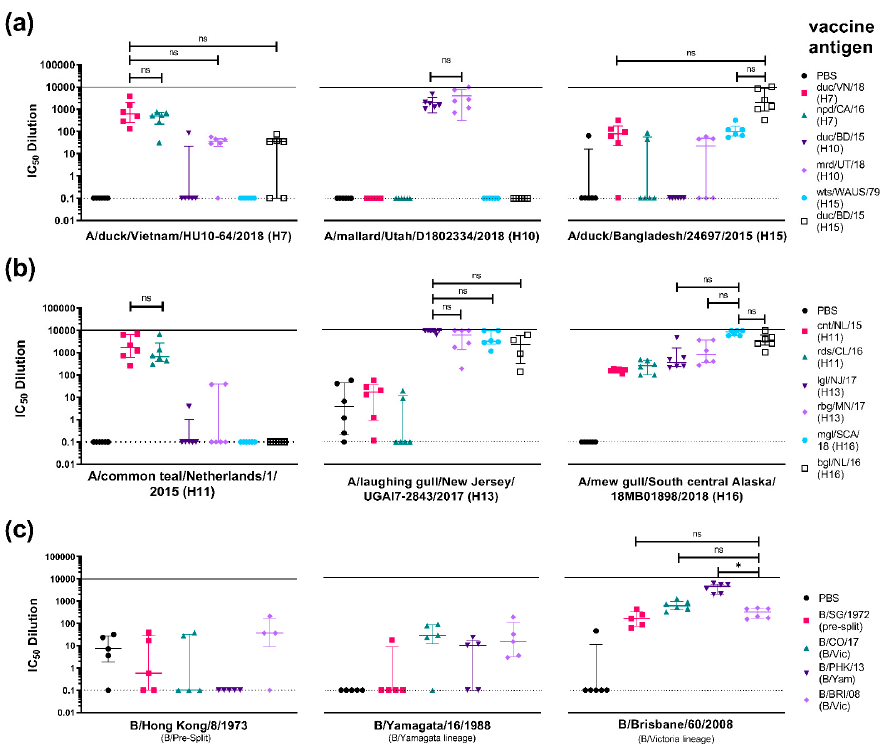
Figure 9. In vitro neutralizing activity as shown by IC 50 dilution of mouse sera vaccinated with HA antigens from the closest phylogenetically related IAV subtypes, ( a ) H7, H10, and H15, ( b ) H11, H13 and H16, and ( c ) IBV HA antigens from pre-split, Yamagata and Victoria like-lineages. Neutralizing activity of sera from vaccinated mice were tested against homologous and heterologous strains from the same subtype and a representative strain within the related subtypes. ( a ) IAV H7/H10/H15 study. Six groups consisting of 6 mice each ( n = 6/group) were vaccinated with 50 µ g of pEVAC expressing A/duck/Vietnam/HU10-64/2018 (H7) (duc/VN/18) (pink square), A/northern pintail duck/California/UCD1582/2016 (H7) (npd/CA/16) (green triangle) ( n = 6), A/duck/Bangladesh/24268/2015 (H10) (duc/BD/15) (violet inverted triangle), A/mallard/Utah/D1802334/2018 (H10) (mrd/UT/18) (purple diamond), A/wedge-tailed shearwater/Western Aus- tralia/2576/1979 (H15) (wts/WAUS/79) (light blue circle), and A/duck/Bangladesh/24697/2015 (H15) (duc/BD/15) (hol- low black square), respectively. Terminal bleeds (70 dpi) were tested against H7 PV duc/VN/18, H10 PV mrd/UT/18, and H15 PV duc/BD/15 as shown on the x-axes. ( b ) IAV H11/H13/H16 study. Six groups consisting of 6 mice each ( n = 6/group) were vaccinated with 50 µ g of pEVAC cloned with A/common teal/Netherlands/1/2015 (H11) (cnt/NL/15) (pink square), A/red/shoveler/Chile/C14653/2016 (H11) (rds/CL/16) (green triangle), A/laughing gull/New Jersey/UGAI7-2843/2017 (H13) (lgl/NJ/17) (violet inverted triangle), A/ring-billed gull/Minnesota/OPMNAI0816/2017 (H13) (rbg /MN/17) (pur- ple diamond), A/black-headed gull/Netherlands/1/2016 (H16) (bhg/NL/16) (light blue circle), and A/mew gull/South central Alas-ka/18MB01898/2018 (H16) (mgl/SCA/18) (black hollow square). Terminal bleeds (70 dpi) were tested against H11 PV cnt/NL/15, H13 PV lgl/NJ/17, and H16 PV mgl/SCA/18 as shown in the x-axes. ( c ) IBV cross lineage study. Four groups of mice were vaccinated with 50 µ g of pEVAC cloned with B/Singapore/222/1979 (presplit) (B/SG/1979) (pink square) ( n = 5), B/Colorado/06/2017 (B/Vic) (B/CO/17) (green triangle) ( n = 6), B/Phuket/3073/2013 (B/Yam) (B/PHK/13) (violet inverted triangle) ( n = 6), and B/Brisbane/60/2008 (B/Vic) (B/BRI/08) (purple diamond) ( n = 6), respectively. Terminal bleeds (70 dpi) were tested against a representative B pre-split PV, B/Hong Kong/8/1973, a rep- resentative B/Yamagata PV, B/Yamagata/16/1988, and B/Victoria PV B/Brisbane/60/2008 as shown in the x-axes. For all plots, an additional group of mice was vaccinated with PBS ( n =5/6). Plots show the median and interquartile range of individual mouse serum samples per immunization group. The solid line indicates an assigned maximum IC 50 dilution of 10,000 showing 100% neutralization and the broken line shows an assigned baseline level of 0.1 indicating 0% neutralization. Comparisons of no significant difference (ns: p > 0.05) and significant difference (* p < 0.05) among IC 50 dilution values with antigen homologous to the PV being tested against is shown in brackets. In the case of ( c ), comparison is made with neutralization of the antigen belonging to the same lineage as the PV it is tested